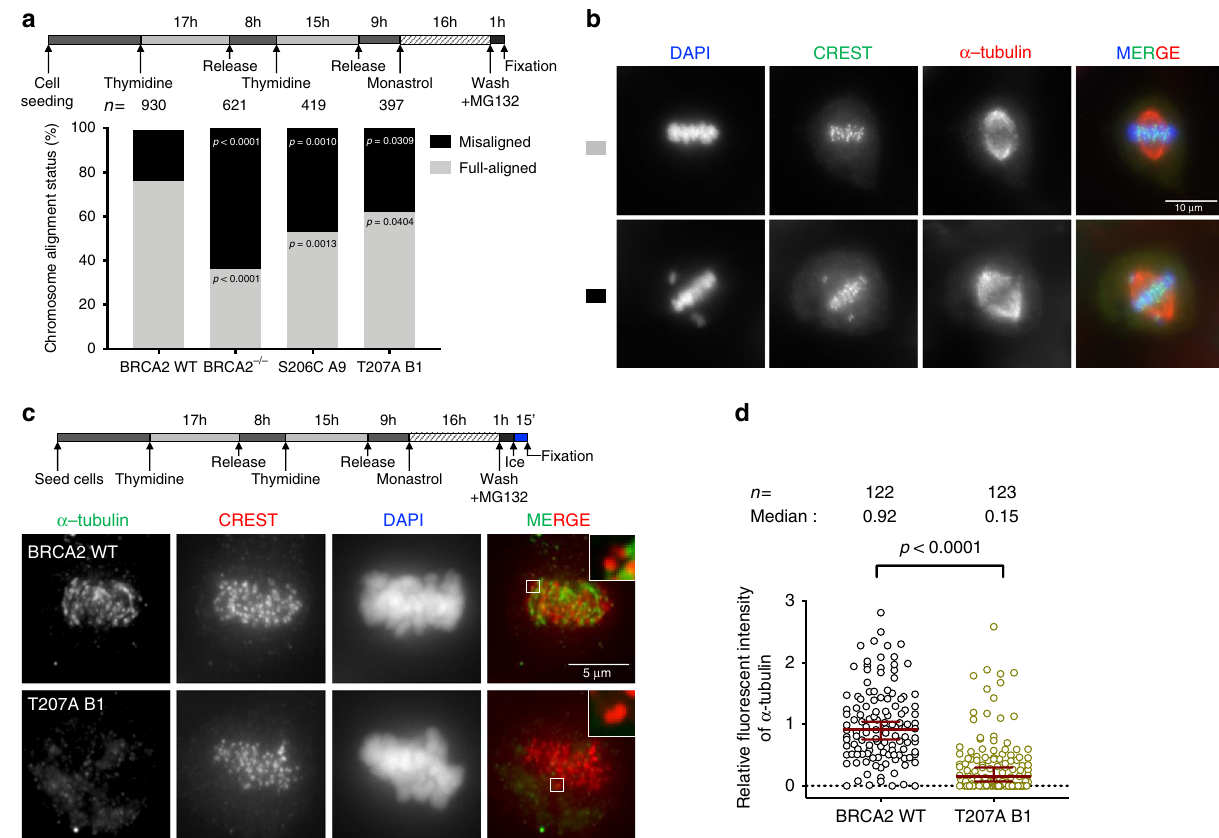
Fig. 6 Cells expressing BRCA2 variants S206C and T207A display reduced stability of kinetochore – microtubule attachments and misaligned chromosomes. a Top: Scheme of the double thymidine block procedure used to synchronize the DLD1 cells for the analysis of chromosome alignment. Bottom: Quanti fi cation of misaligned chromosomes outside the metaphase plate in DLD1 BRCA2 de fi cient cells (BRCA2 − / − ) and BRCA2 − / − cells stably expressing BRCA2 WT or the S206C and T207A variants. n indicates the total number of cells counted for each clone from two (BRCA2 − / − , S206C, and T207A) and four (BRCA2 WT) independent experiments. Statistical signi fi cance of the difference was calculated with unpaired two-way ANOVA test